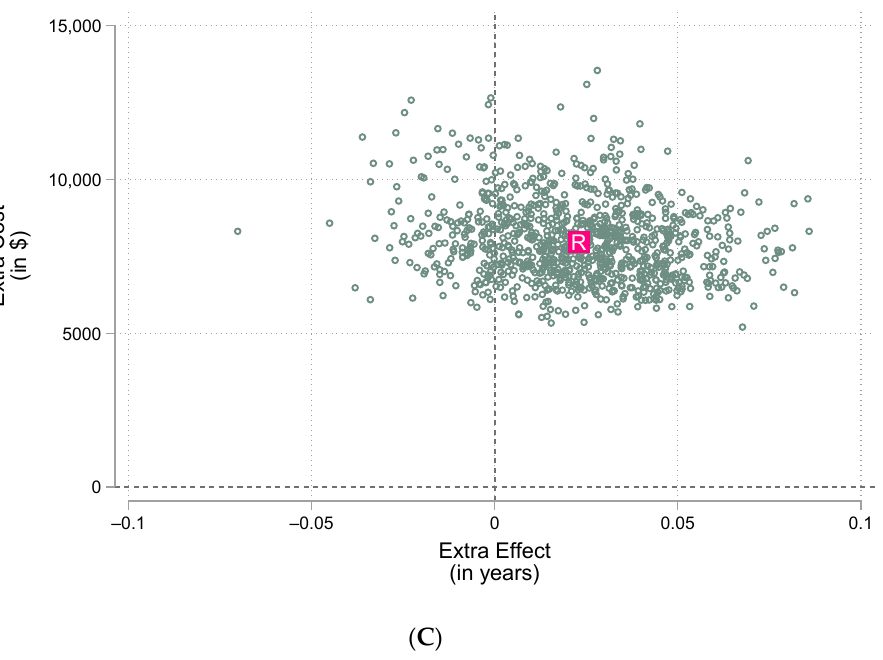
Figure 1. ( A ) Incremental cost-effectiveness ratio (ICER) illustrated on a cost-effectiveness plane. ( B ) The ICER and its 95% confidence interval illustrated on a cost-effectiveness plane. ( C ) The scatterplot approach to showing ICER uncertainty on a cost-effectiveness plane